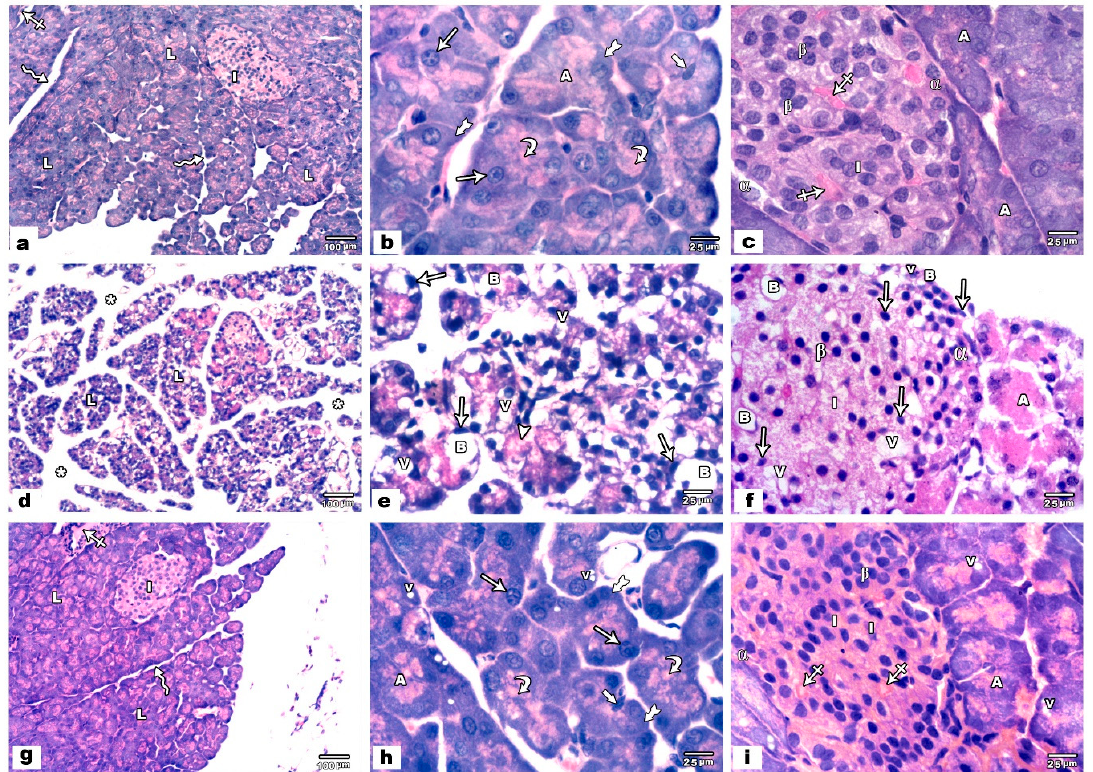
Figure 1. Photomicrographs of H&E-stained pancreatic sections. Control sections ( a – c ). ( a ) The pancreas of these groups consists of several adjacent lobules (L) of variable sizes and shapes separated by thin septa (zigzag arrows) containing blood vessels (crossed arrow). Pale pink oval islets of Langerhans (I) are also seen. ( b ) The lobules exhibit tightly packed acini (A) with narrow lumina occupied by small centroacinar cells with oval nuclei (thick arrow). The cells of the acini are pyramidal in shape with rounded, basal, and vesicular nuclei (arrow). The cytoplasm of them shows basal basophilia (tailed arrow) and apical acidophilic zymogen granules (curved arrow). ( c ) The islets of Langerhans (I) are present among the pancreatic acini (A) and formed of β cells ( β ) in the center of the islets and peripheral α cells ( α ) with pale cytoplasm and rounded vesicular nuclei disconnected by blood capillaries (crossed arrow). Sodium valproate (VPA) treated pancreatic sections ( d – f ). ( d ) Widening of the interstitial tissue (asterisk) between the lobules (L) is noticed. ( e ) Many acinar cells show pyknotic nuclei (arrows), vacuolated cytoplasm (V), and ballooning of some cells (B). Acidophilic fibrillar cytoplasm is seen in some acinar cells (arrow head). ( f ) The islets of Langerhans (I) are present among the pancreatic acini (A) and show pyknotic nuclei (arrows) with ballooning (B) and vacuolation (V) of the cytoplasm of α ( α ) and β ( β ) cells. VPA and alpha-lipoic acid (ALA) treated pancreatic sections ( g – i ). ( g ) The pancreas of this group consists of several adjacent lobules (L) separated by thin septa (zigzag arrows) containing blood vessels (crossed arrow) and islets of Langerhans (I) ( h ) The lobules exhibit many closely packed acini (A) with narrow lumina. The lumen of the acini is occupied by centroacinar cells with oval nuclei (thick arrow). The cells of the acini are pyramidal in shape with rounded, basal, vesicular nuclei (arrow) its cytoplasm has basal basophilia (tailed arrow) and apical acidophilic zymogen granules (curved arrow). Vacuolated cytoplasm (V) is seen in some acinar cells. ( i ) The islets of Langerhans (I) are present in between the pancreatic acini (A) and formed of β cells in the center of the islets ( β ) and peripheral α cells ( α ) disconnected by blood capillaries (crossed